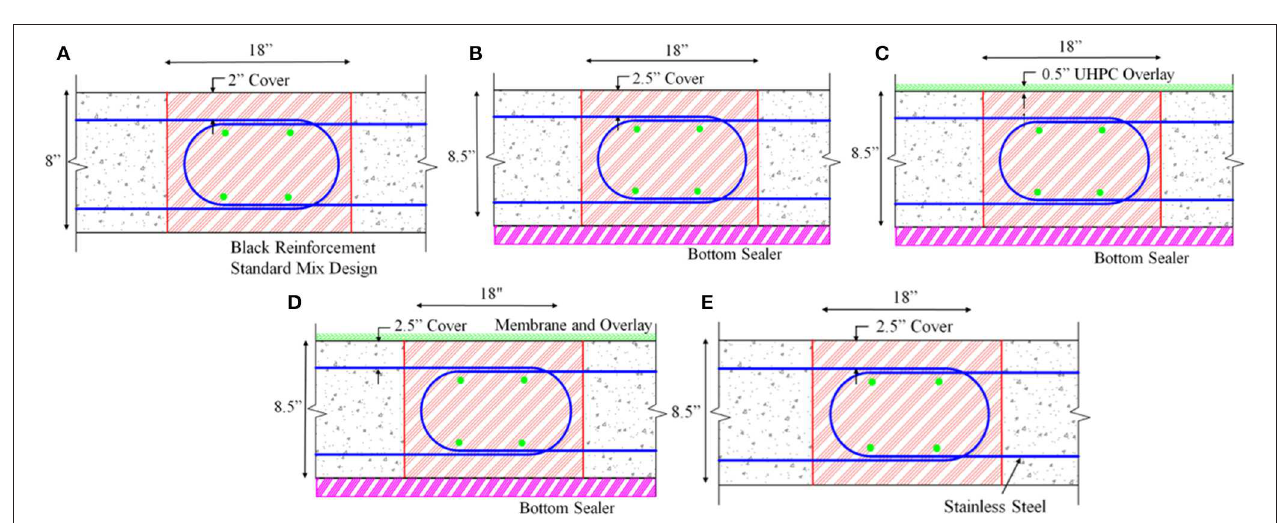
FIGURE 10 | Closure joint Alternative 3, using NSC with 180 ◦ hooked bars (A) strength design, (B) Option 1, (C) Option 2, (D) Option 3, and (E) Option 4.